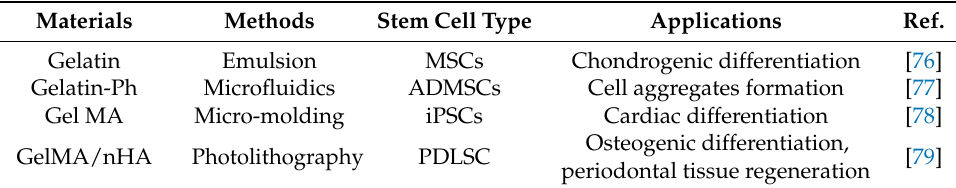
Table 3. Examples of gelatin-based stem cell microencapsulation.